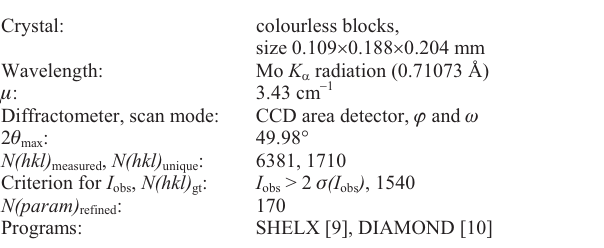
Table 1. Data collection and handling.